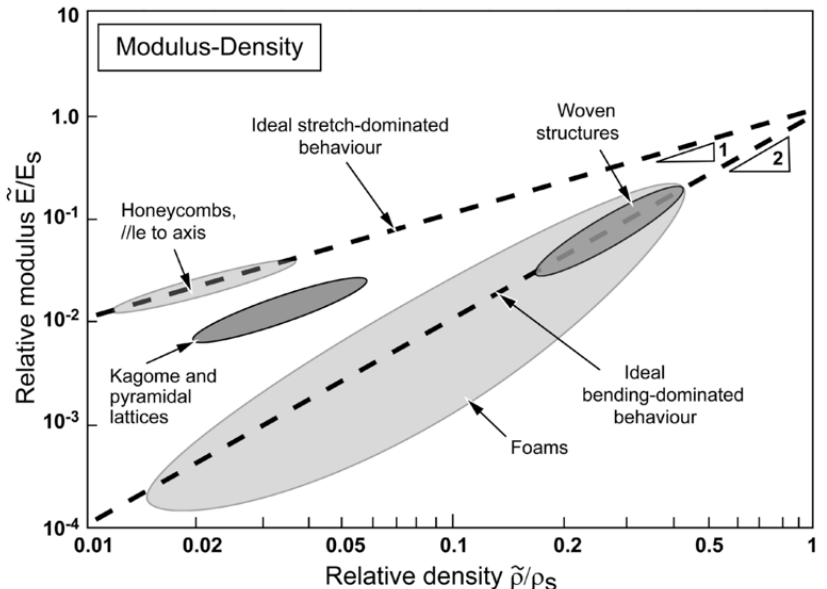
Figure 3. Relative modulus plotted against relative density on logarithmic scales for cellular struc- ture [19] .